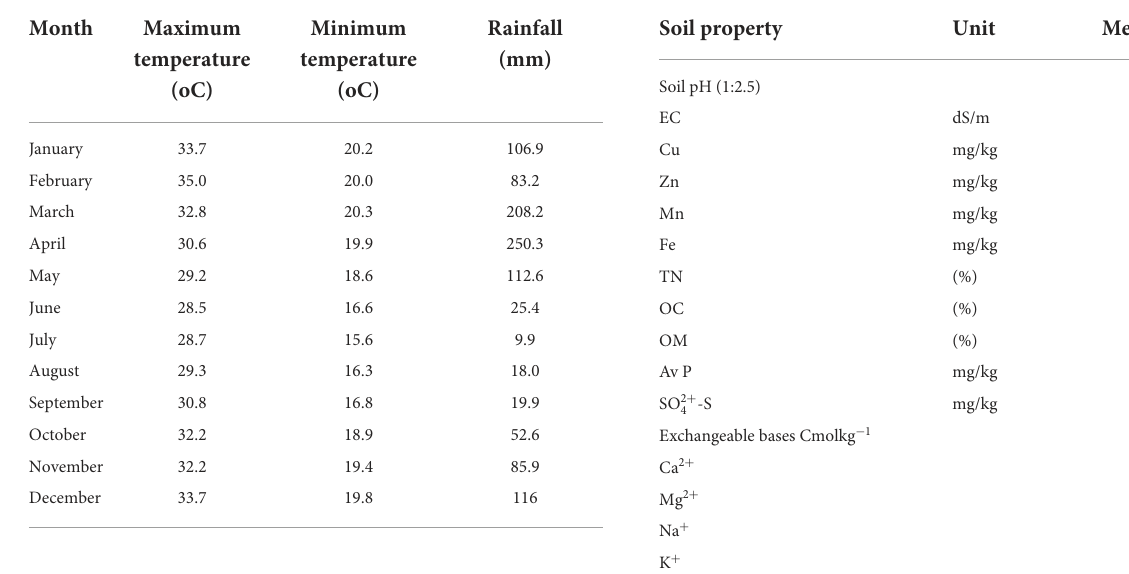
TABLE 1 Average temperature and rainfall of Mkindo Climatic conditions 1999-2020.